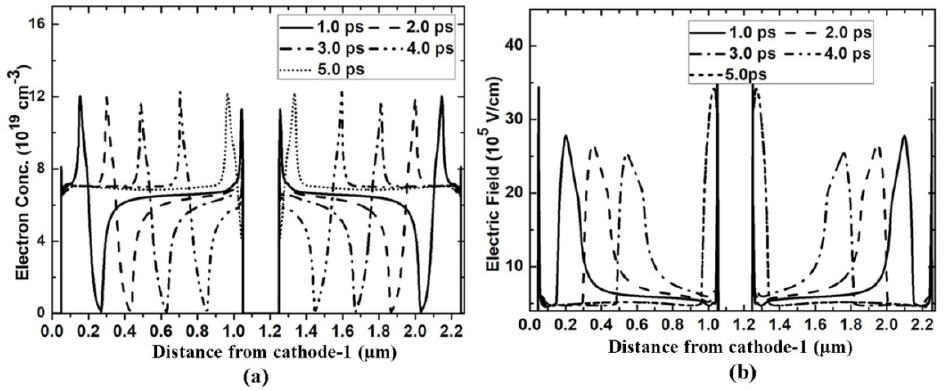
Figure 5. ( a ) Electron concentration and ( b ) Electric field profiles in one oscillation period in the grooved-anode diode as L = 2.0 µm.